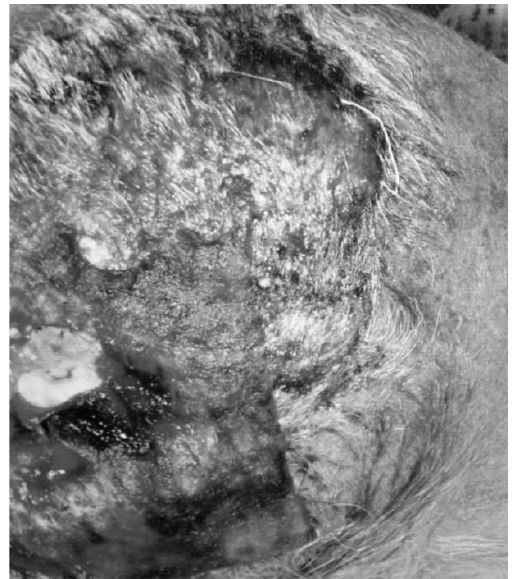
Fig. 2. Extensive cutaneous angiosarcoma extending over the scalp with central